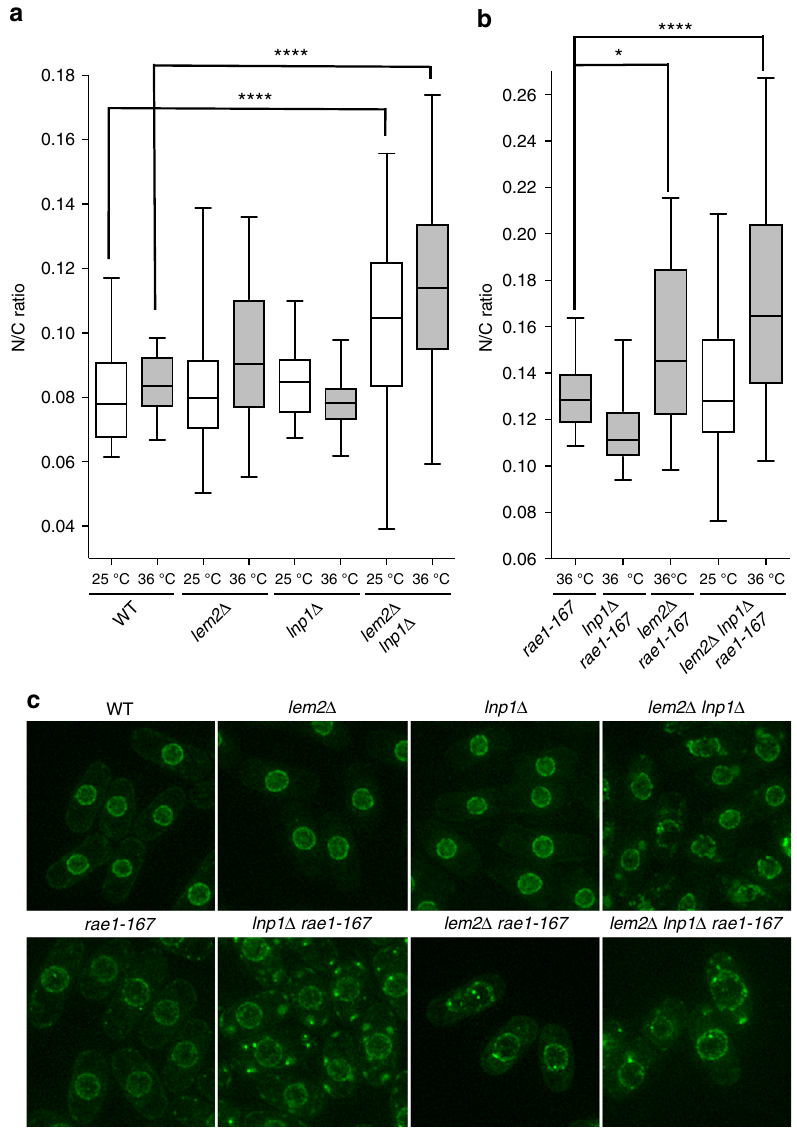
Fig. 4 Lnp1 compensates for loss of Lem2 to aid preservation of nuclear size. a N/C ratio of wild type (WT), lem2 Δ , lnp1 Δ , and lem2 Δ lnp1 Δ cells grown at 25 °C then shifted to the indicated temperature for 4 h ( n > 30 cells). Two-tailed Mann – Whitney test: **** P < 0.0001, lem2 Δ lnp1 Δ (25 °C) ( n = 32 cells) and lem2 Δ lnp1 Δ (36 °C) ( n = 54 cells) against WT ( n = 35 cells); lnp1 Δ (25 °C) ( n = 59 cells) and lnp1 Δ (36 °C) ( n = 31 cells) against WT ( n = 35 cells), P = 0.0647 and 0.0788, respectively. The corresponding dot plot is available in Supplementary Fig. 9f. b N/C ratio of rae1-167, lnp1 Δ rae1-167, lem2 Δ rae1- 167 , and lem2 Δ lnp1 Δ rae1-167 cells grown at 25 °C then shifted to the indicated temperature for 4 h ( n > 30 cells). Two-tailed Mann – Whitney test: * P = 0.0139, **** P < 0.0001, lem2 Δ rae1-167 ( n = 31 cells) and lem2 Δ lnp1 Δ rae1-167 ( n = 31 cells) against rae1-167 ( n = 67 cells). The corresponding dot plot is available in Supplementary Fig. 9g. c Images of the nuclear envelope (Cut11-GFP, green) of wild type (WT), lem2 Δ , lnp1 Δ , lem2 Δ lnp1 Δ , rae1-167, lnp1 Δ rae1- 167, lem2 Δ rae1-167, and lem2 Δ lnp1 Δ rae1-167 cells grown at 25 °C then shifted to 36 °C for 4 h. Maximum intensity projections shown. Scale bar: 5 µ m. In all box-and-whiskers diagrams, boxes indicate median and upper and lower quartile and whiskers indicate range of